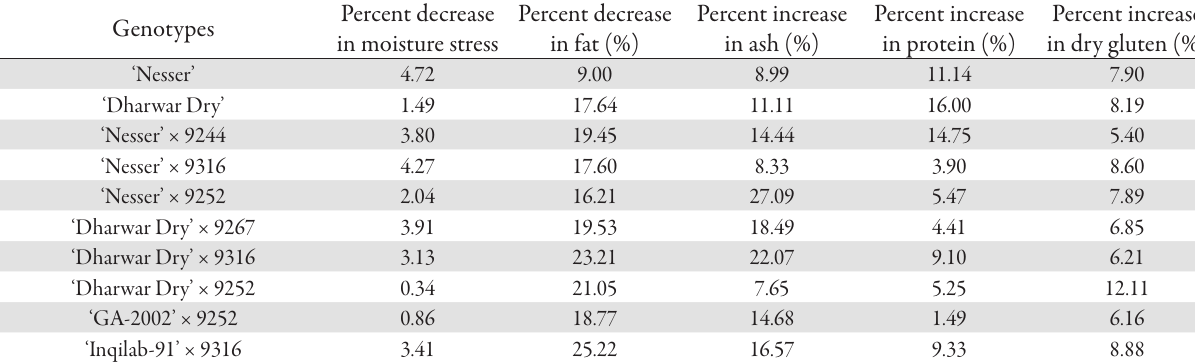
Tab. 1. Percent decrease in wheat quality traits due to water stress conditions